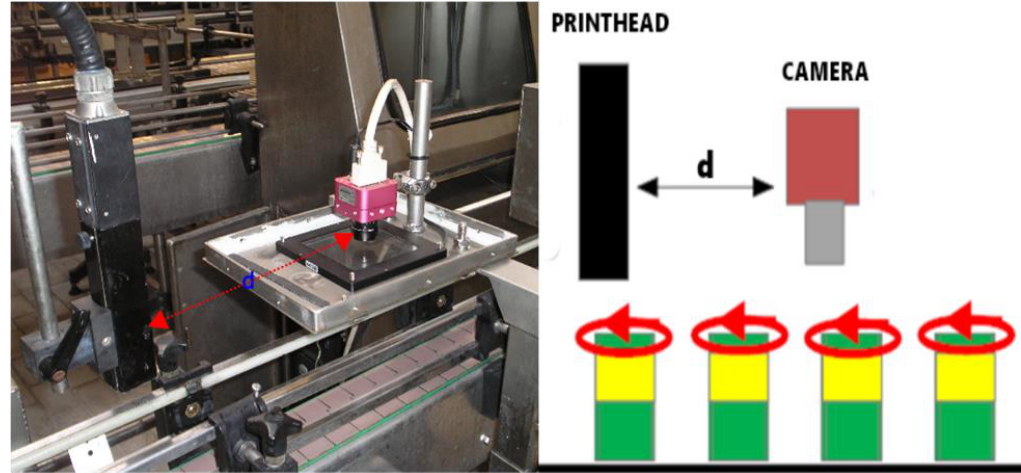
Figure 3. By reducing distance d (to less than one metre), the issue of rotational invariance is considerably mitigated.